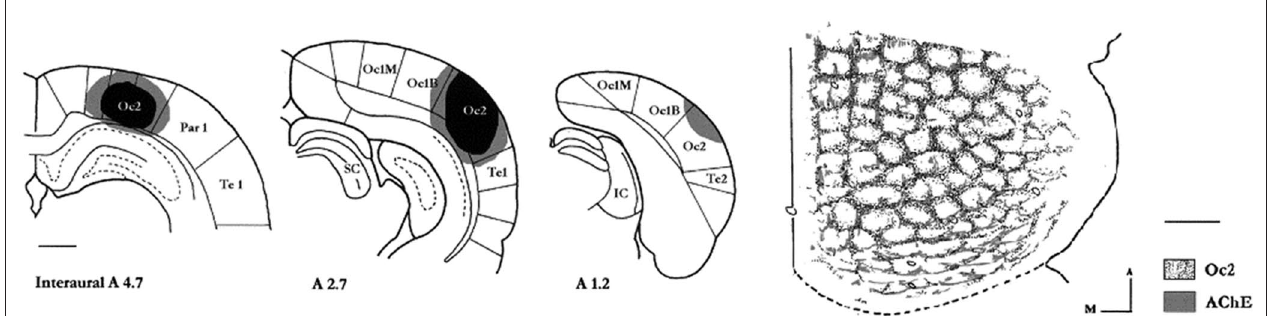
similar pattern shown by histochemistry for acetylcholinesterase (AChE). A, anterior; m, medial. Modified from Figure 1 from Mana and Chevalier, 2001. Scale bars = 1 mm for section outlines; 500 μm for tangential